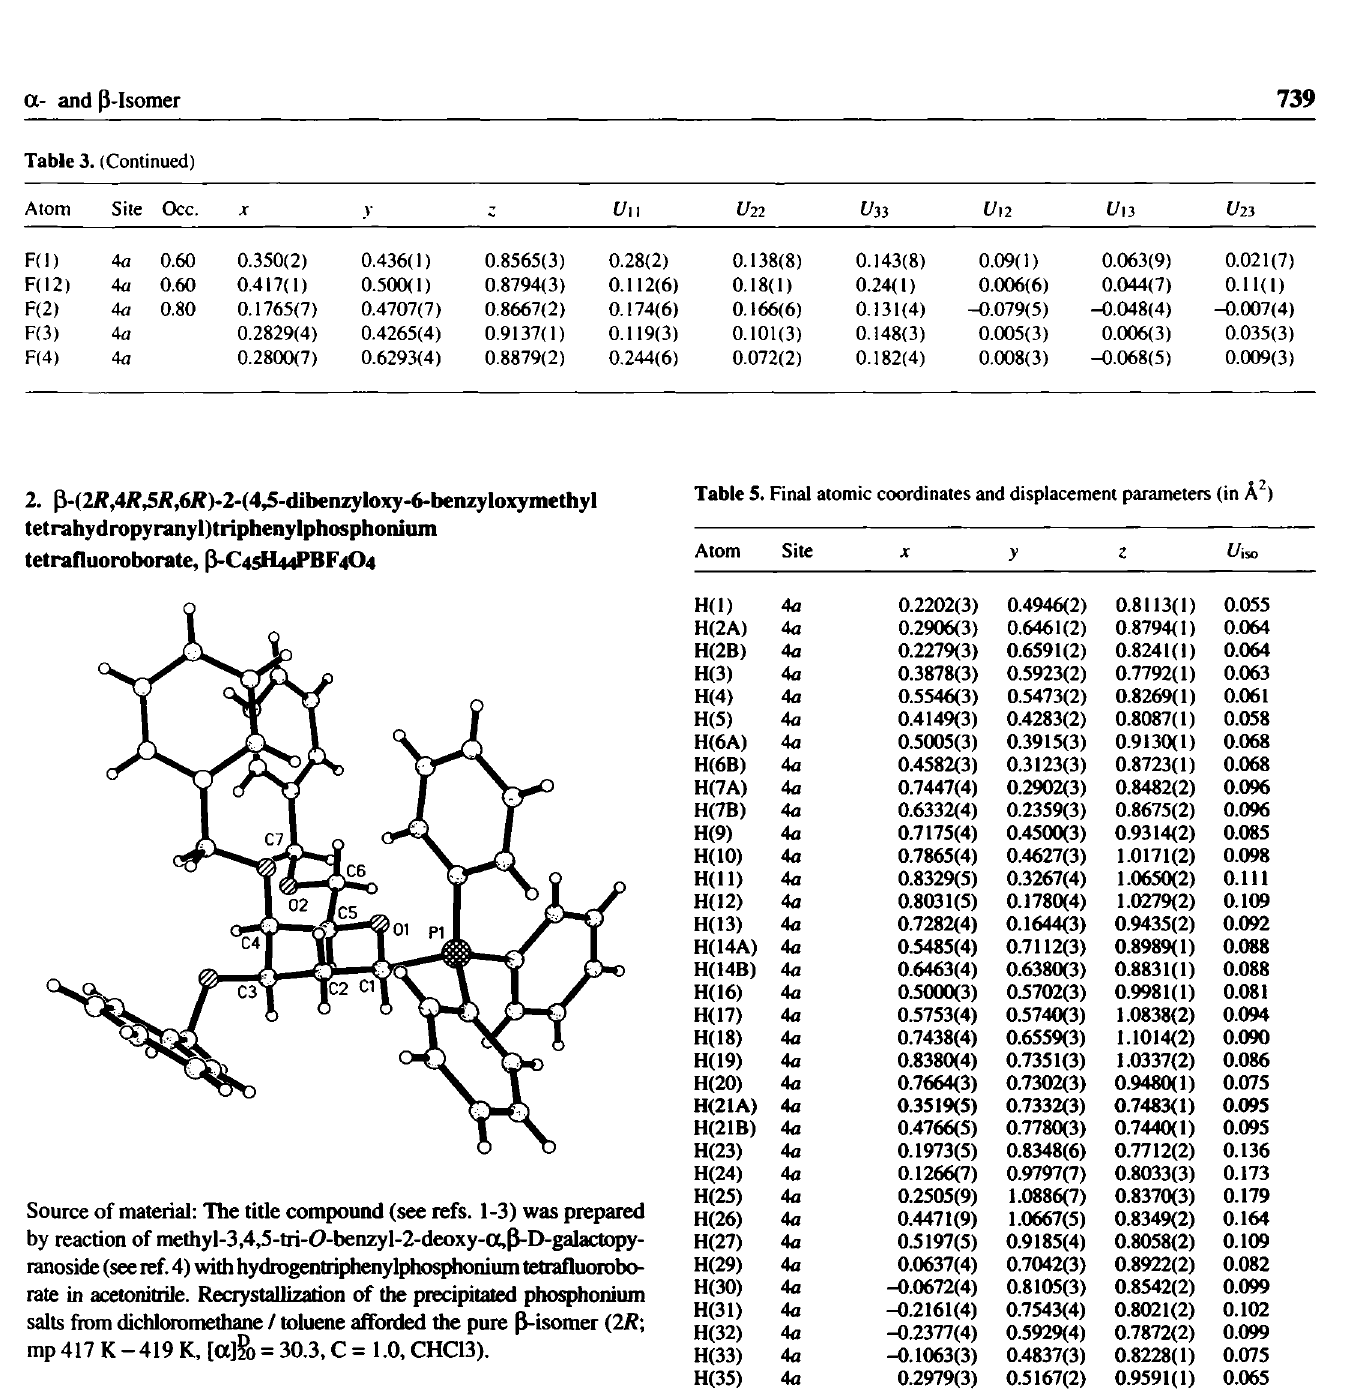
Table 4. Parameters used for the X-ray data